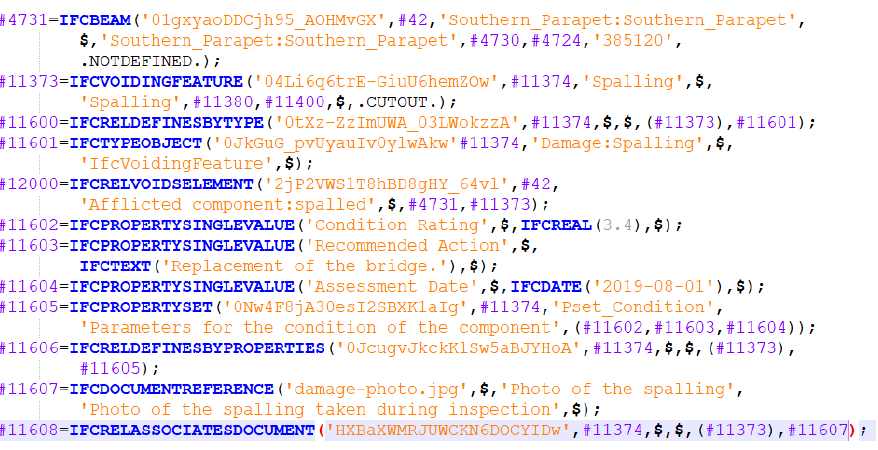
Figure 16. Excerpt of the resultant IFC file.